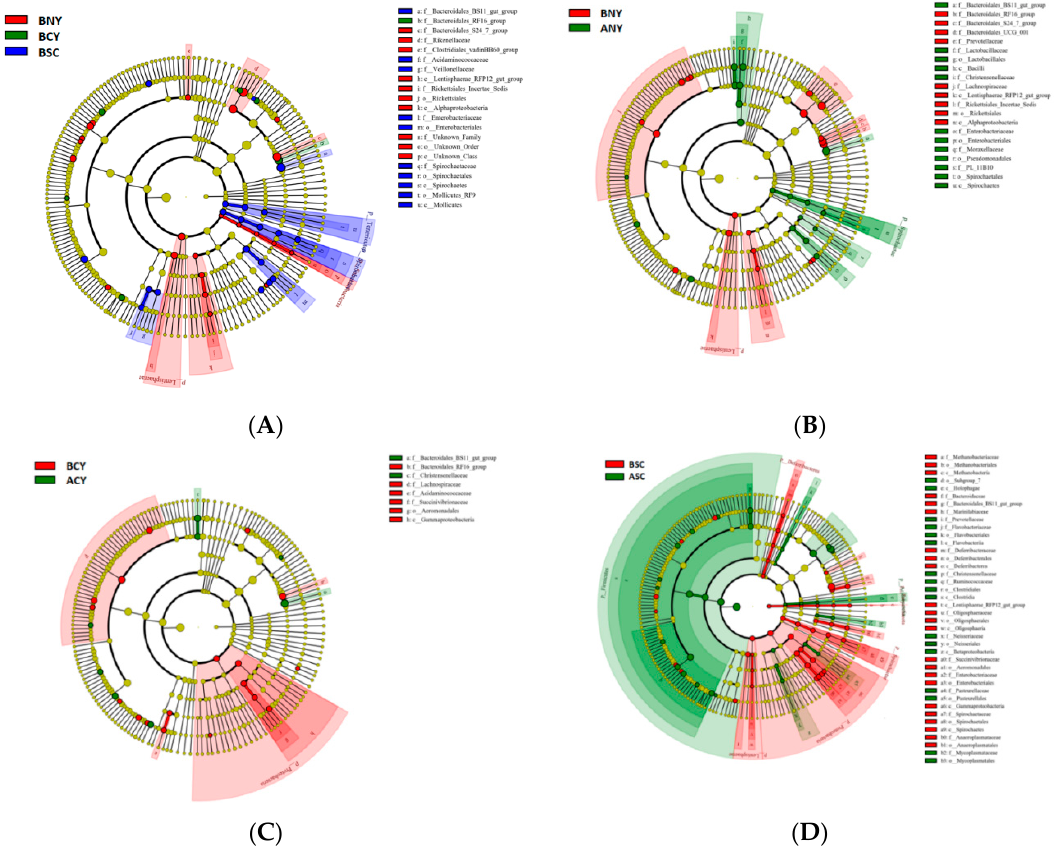
Figure 4. LEfSe identified the most di ff erentially abundant taxons in NY, SC, and CY ( A ) before transport, BNY and ANY ( B ), BSC and ASC ( C ), BCY and ACY ( D ). Taxonomic cladogram obtained from LEfSe analysis of 16 S sequences (relative abundance ≥ 0.5%). (red) BNY-enriched taxa, (blue) taxa enriched in BSC, (green) taxa enriched in BCY ( A ), (red) BNY-enriched taxa, (green) taxa enriched in ANY ( B ), (red) BCY-enriched taxa, (green) taxa enriched in ACY ( C ), (red) BSC-enriched taxa, (green) taxa enriched in ASC ( D ). The brightness of each dot is proportional to its e ff ect size. Phylum: p (put “p” in front of the microbes or don’t use italics), class: c(put “c” in front of the microbes and use italics), order: o(put “o” in front of the microbes and use italics), family: f (put “f” in front of the microbes and use italics), genus: g(put “g” in front of the microbes and use italics or not put “g” in front of the microbes but use italics) and species: s (put “s” in front of the microbes and use italics), all data were